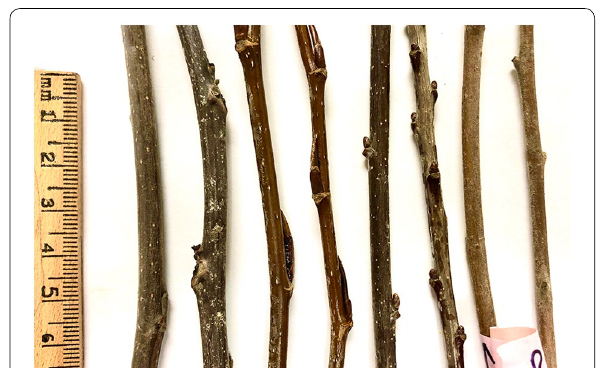
Fig. 2 Samples from each species illustrating some of the variations in node frequency across different shoots. Two stems are included from each species and the species are arranged from left to right as follows: Juglans californica , Populus trichocarpa , Quercus robur , and Rhus aromatica